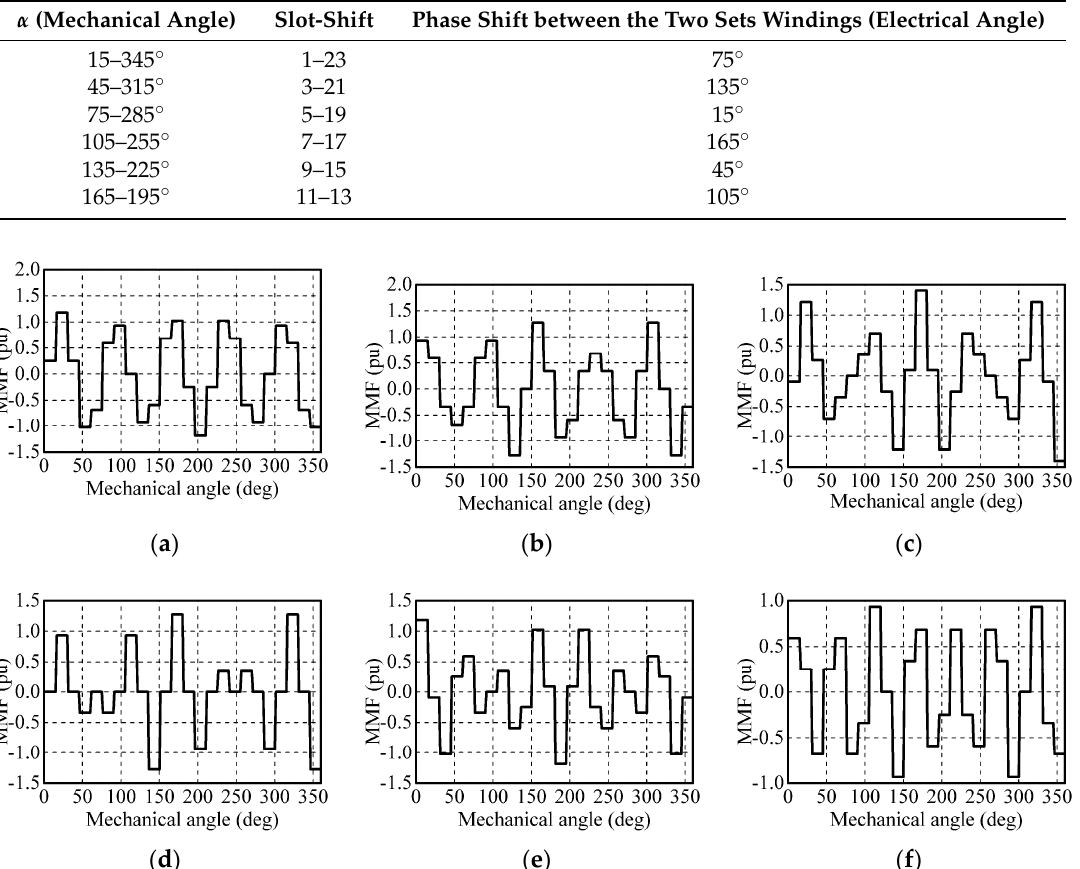
Figure 4. MMF distributions for different phase shifts between the two sets of 12-slot/10-pole windings: ( a ) 15°; ( b ) 45°; ( c ) 75°; ( d ) 105°; ( e ) 135°; ( f ) 165°.